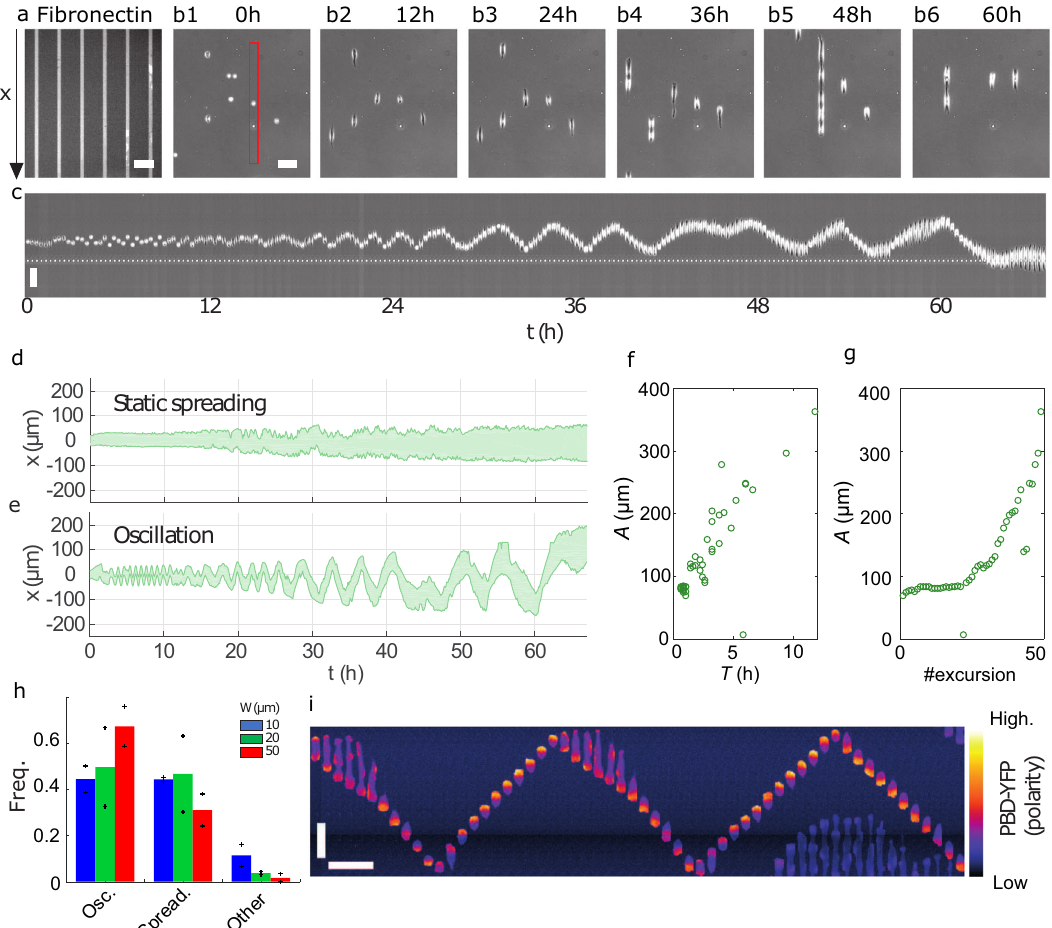
Fig. 1 Isolated cells exhibit regular oscillations. a Fluorescent tracks of fi bronectin of width W = 20 μ m. b1 – b6 Snapshots of MDCK cells observed using phase-contrast imaging. c Kymograph of a single MDCK cell (red frame in b1 ) showing oscillations. d , e . Typical kymographs of a statically spreading ( d ) and an oscillating ( e ) cell plated on lines with W = 20 μ m. f , g Amplitude of the oscillations measured in panel e as a function of their period ( f ) and as a time series ( g ). h Frequency of the various behaviours (oscillating, spreading and other) of isolated MDCK cells on lines of different widths. n = 61, 131 and 87 trajectories for W = 10, 20 and 50 μ m from six independent experiments (2 per track width). Mean (bars) and single repeats (plus signs). i Kymograph of a MDCK cell expressing PBD-YFP, a reporter of Rac1/Cdc42 activation, hence of the cytoskeleton polarity. Individual frames are separated by 10 min. Typical behaviour observed in 2 independent experiments with PBD-YFP cells. All scale bars, 100 μ